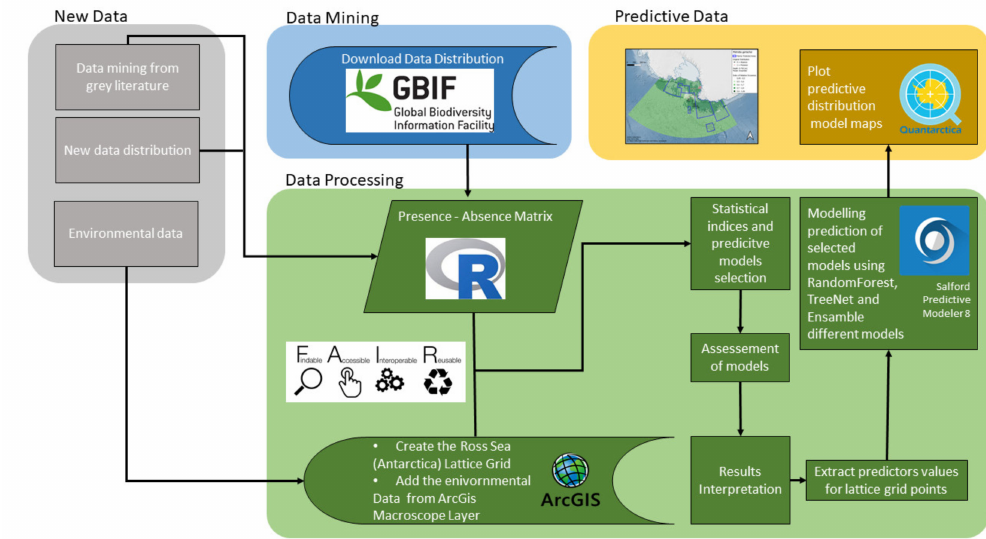
Figure 2. Workflow of the data analysis. This workflow represents the work steps that led to the species distribution models. This diagram shows data mining, data processing, new data, and predictive data.